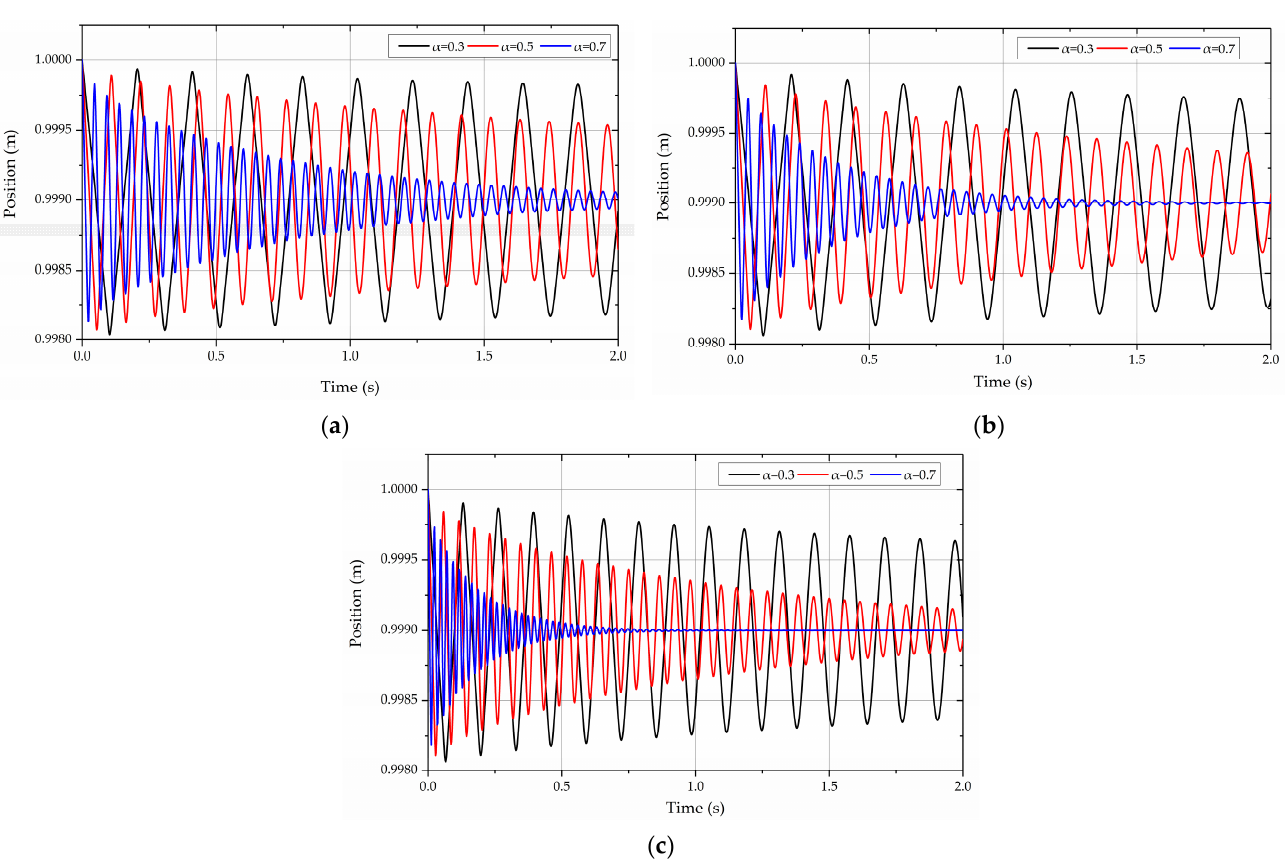
Figure 3. x-component of the position vector of the free tip with different parameters.